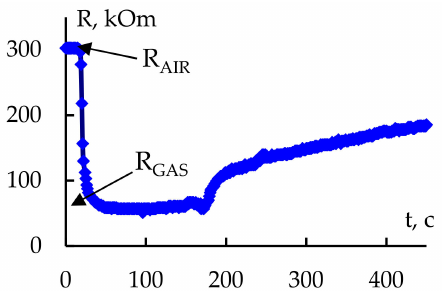
Figure 16. Typical temporal dependency of resistance of net-like nanocomposite during and just after introduction of reagent